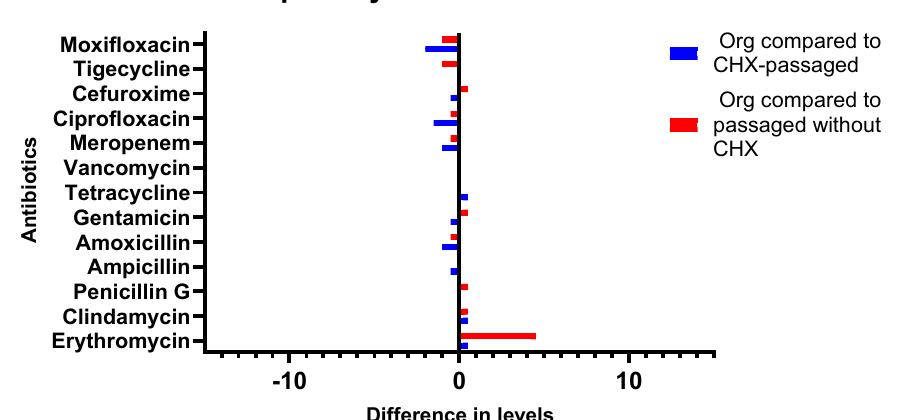
Figure 6. Antibiotic susceptibility testing of S. oralis isolates from Subject 4–Subject 6. Graphical depiction of the difference of susceptibilities in levels between the original isolate and the isolates after passage with and without CHX. The levels are drawn on the X-axes, and the antibiotics are shown on the Y-axes. P4–P6: Probands 4–6.